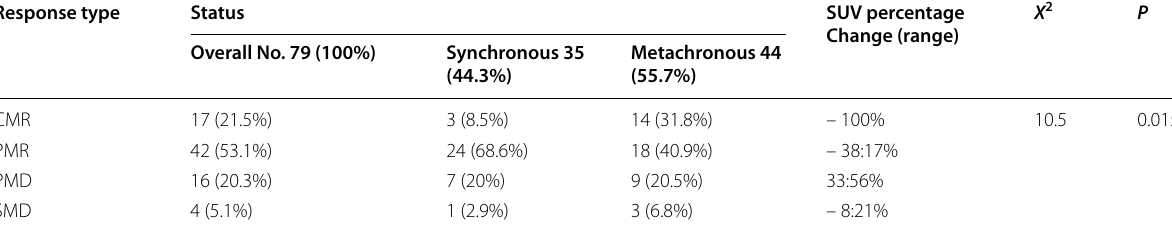
* P 1 between baseline in both groups * P 2 between F.U of both groups Table 4 Overall Response according to PERCIST Criteria Response type